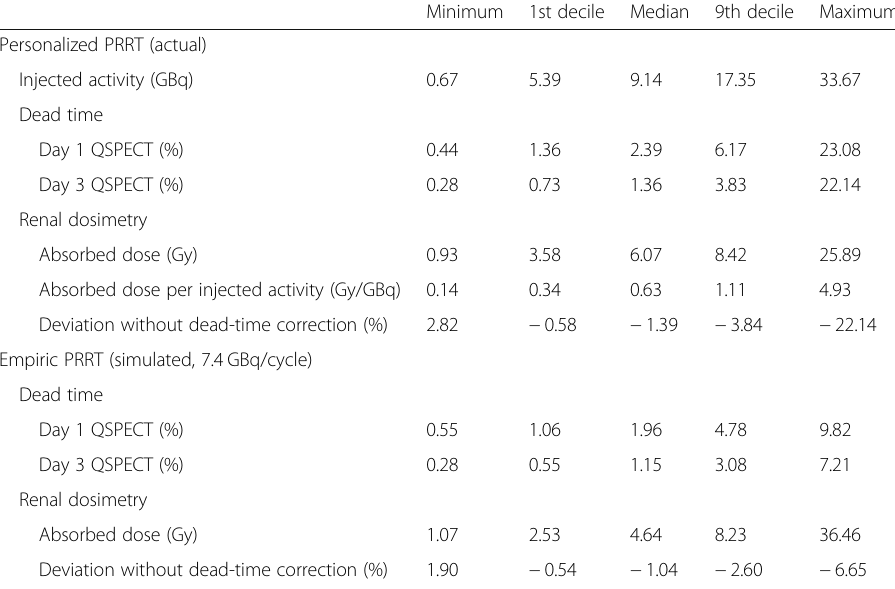
Table 1 Injected activity, dead time and dosimetry data for personalized and simulated empiric PRRT cycles ( n = 564) Minimum 1st decile